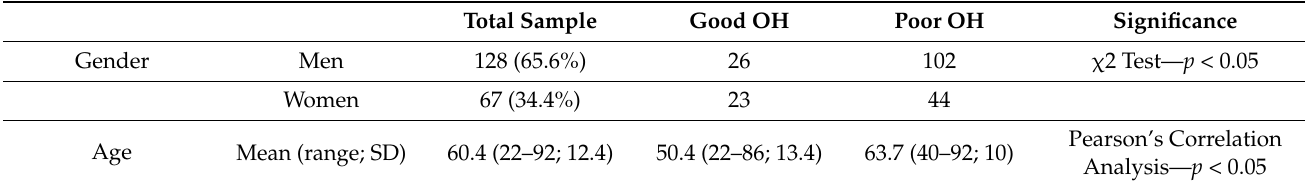
Table 1. General characteristics of the population and correlation with